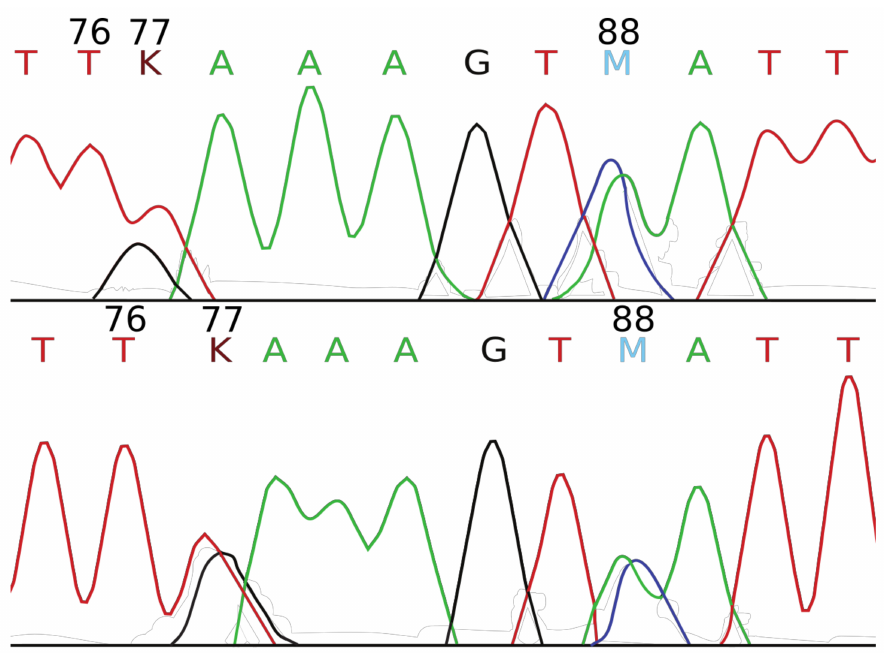
Figure 2. Portions of forward (top) and reverse (bottom) Sanger sequencing chromatograms demon- strating polymorphic positions (alignment positions 77 and 88) in herbal supplement mini-barcode sequences of a Type C sequence. Diagnostic nucleotides (Figure 1) are indicated by their alignment position; “A” = green; “G” = black; “K” = maroon {GT}; “M” = indigo {AC}; “T” = red. Despite the supplement being labeled as containing only H. procumbens , alignment position 76 indicates that this sample is composed exclusively of H. zeyheri